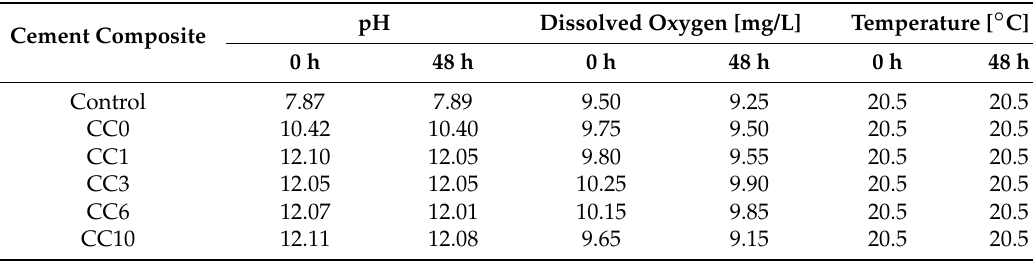
Table 7. Physico-chemical indicators of water leachates of concrete composites over the acute toxicity test of Daphnia